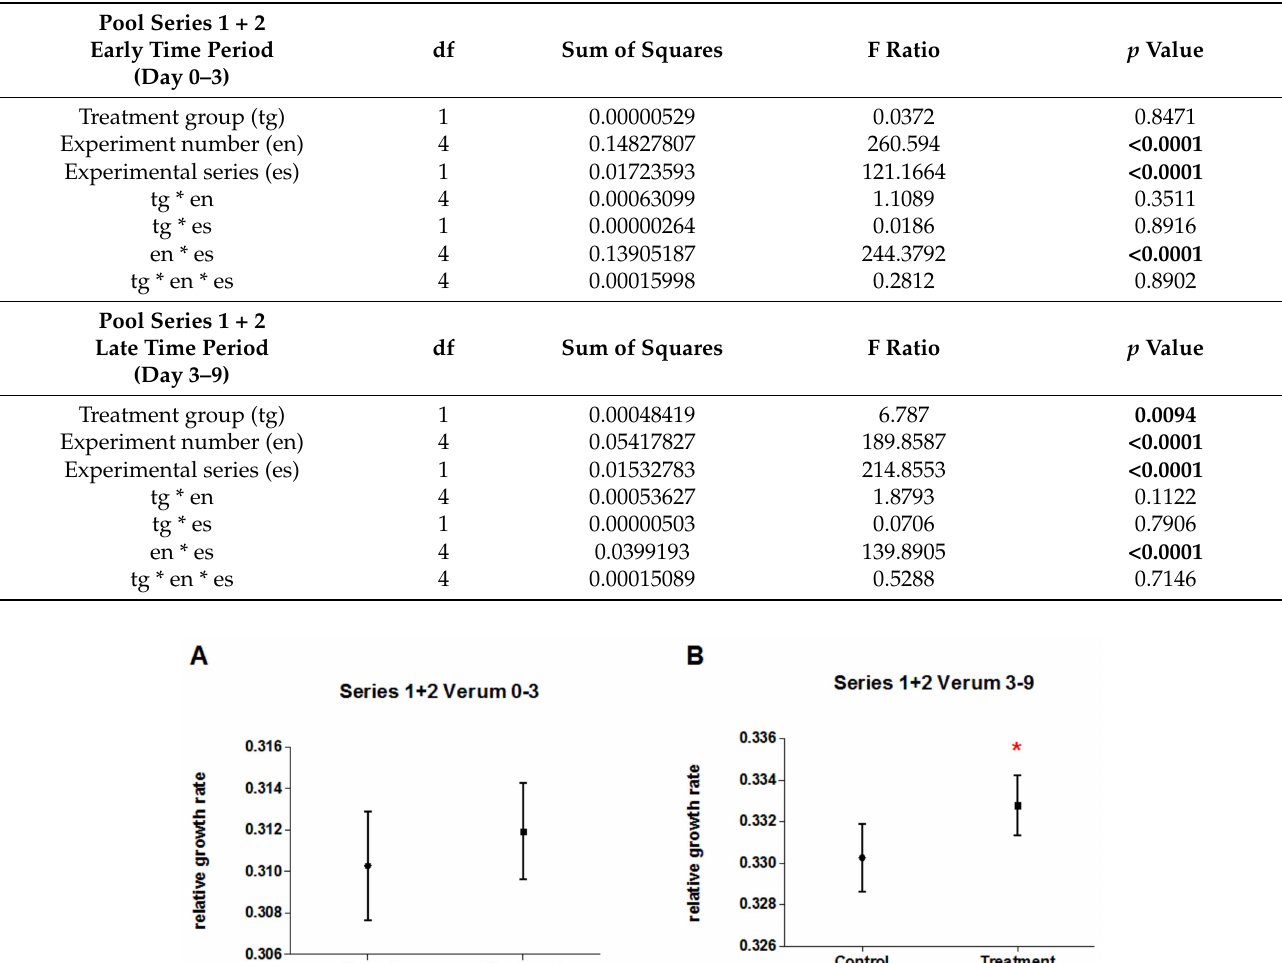
Table 7. Statistical analysis of experimental series 1 and 2. Results of three-way ANOVA for numeri-